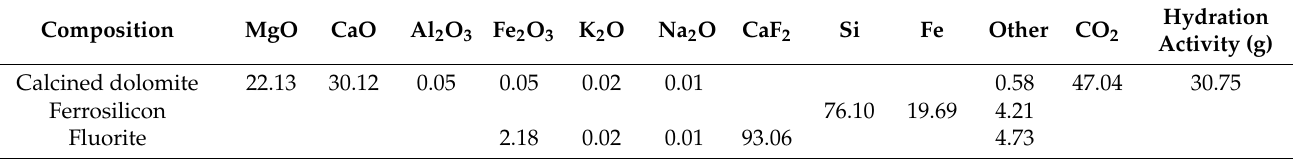
Table 1. Composition and calcining index of calcined dolomite